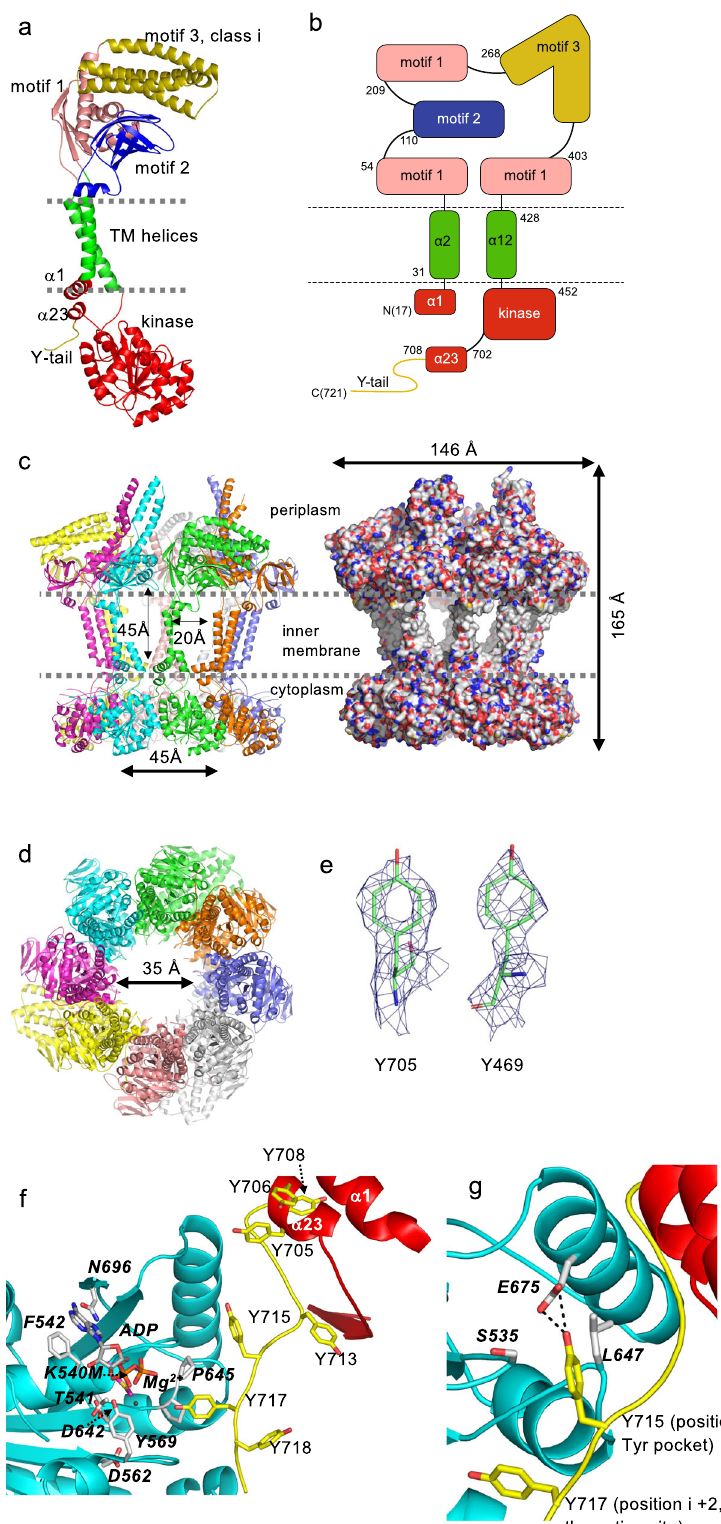
For ease of discussion, each protomer can be decomposed into three portions: the periplasmic region (residues 51 – 427), the transmembrane region (31 – 50, 428 – 447) and the cytoplasmic region (17 – 30, 448 – 721) (Fig. 2a, b). The Wzc K540M octamer is ~165 Å high (cytosol to periplasm) and 146 Å wide and possesses